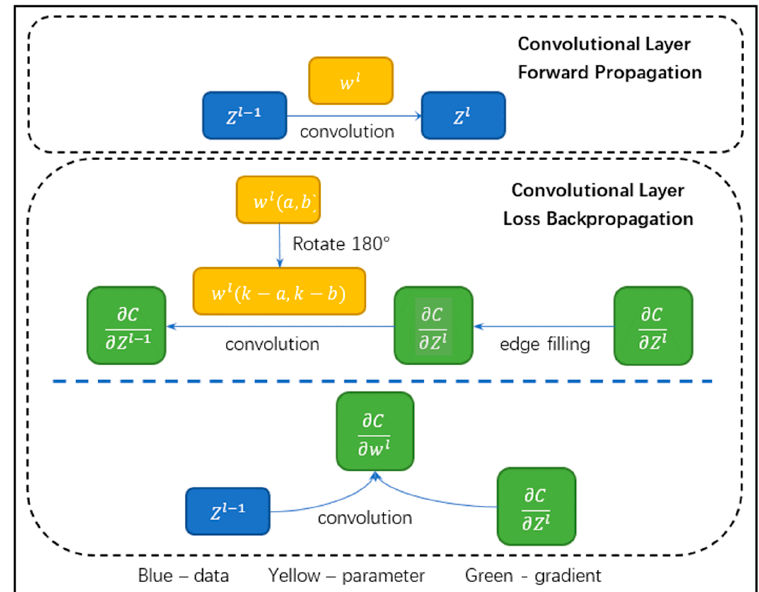
Figure 6. Data propagation in the convolution layer. Forward propagation of the convolution layer is expressed as: